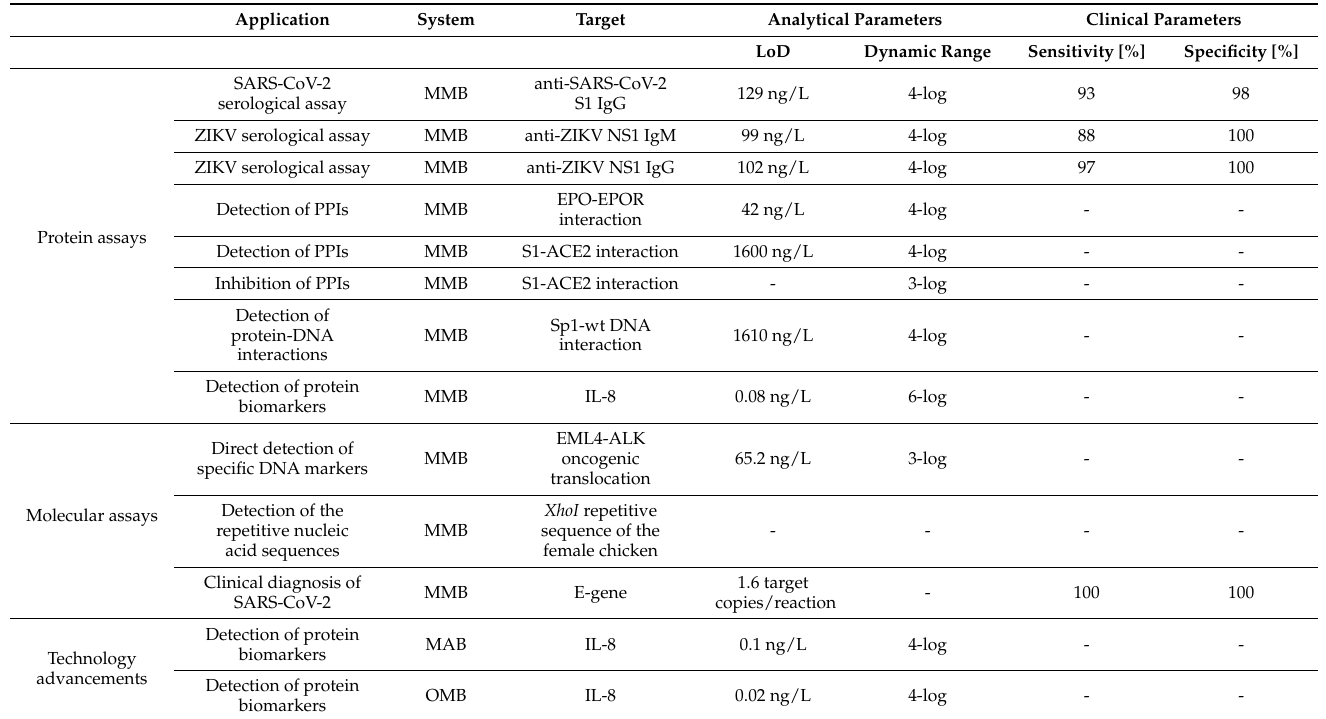
Table 1. Summary of different applications using the MMB and its